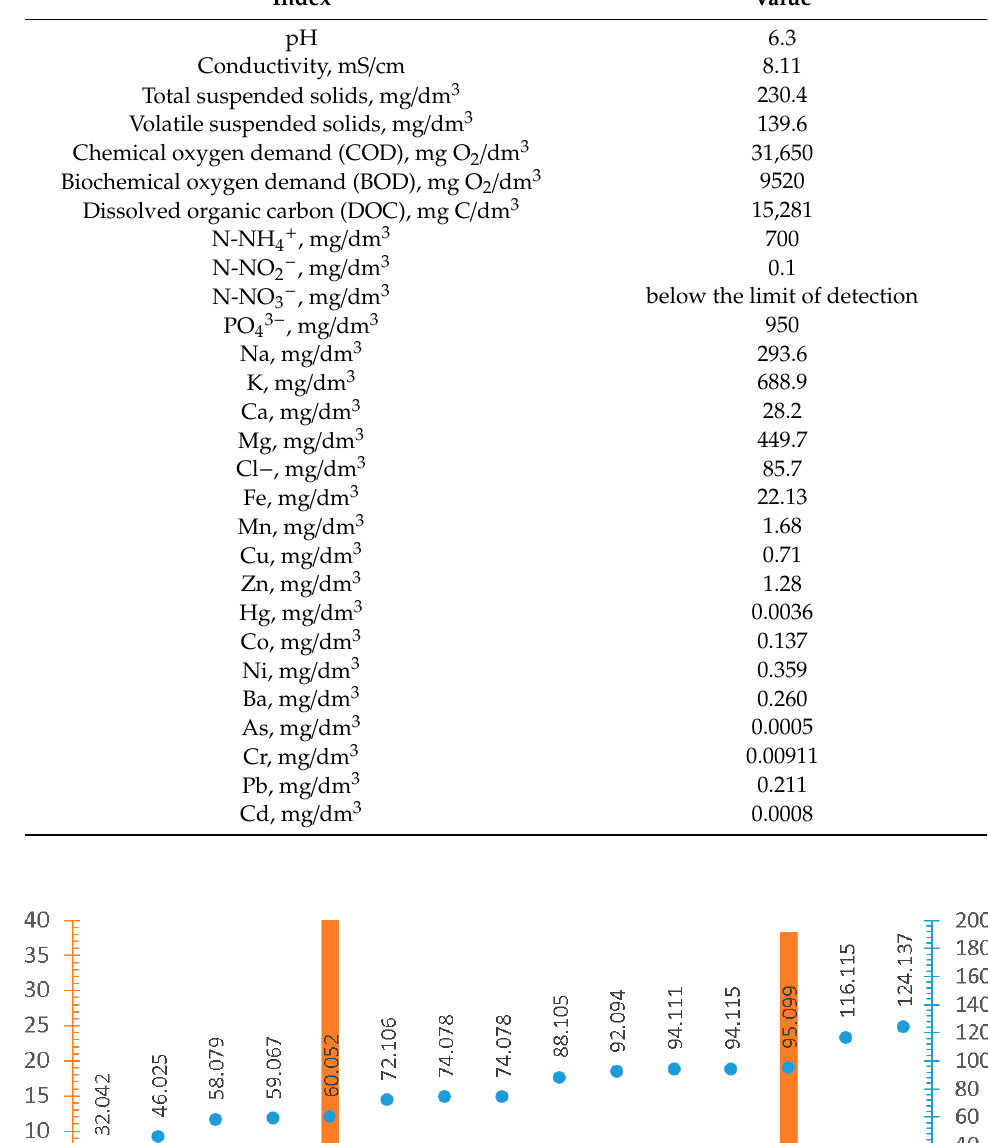
Table 2. The composition of the liquid fraction obtained after hydrothermal carbonization (HTC) of a rural anaerobic digestion plant digestate.